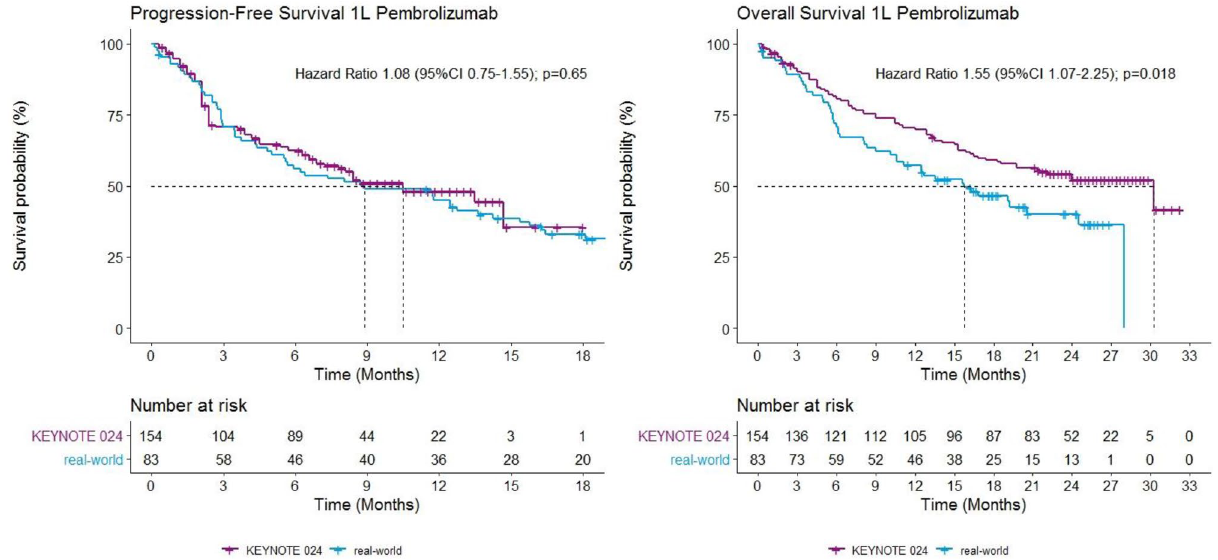
Figure 2. Kaplan–Meier curves of PFS and OS in patients receiving 1L pembrolizumab in real-world and clinical trial.